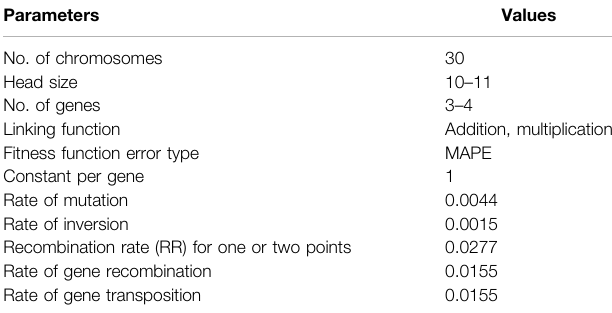
TABLE 5 | Different parameters of GEP.